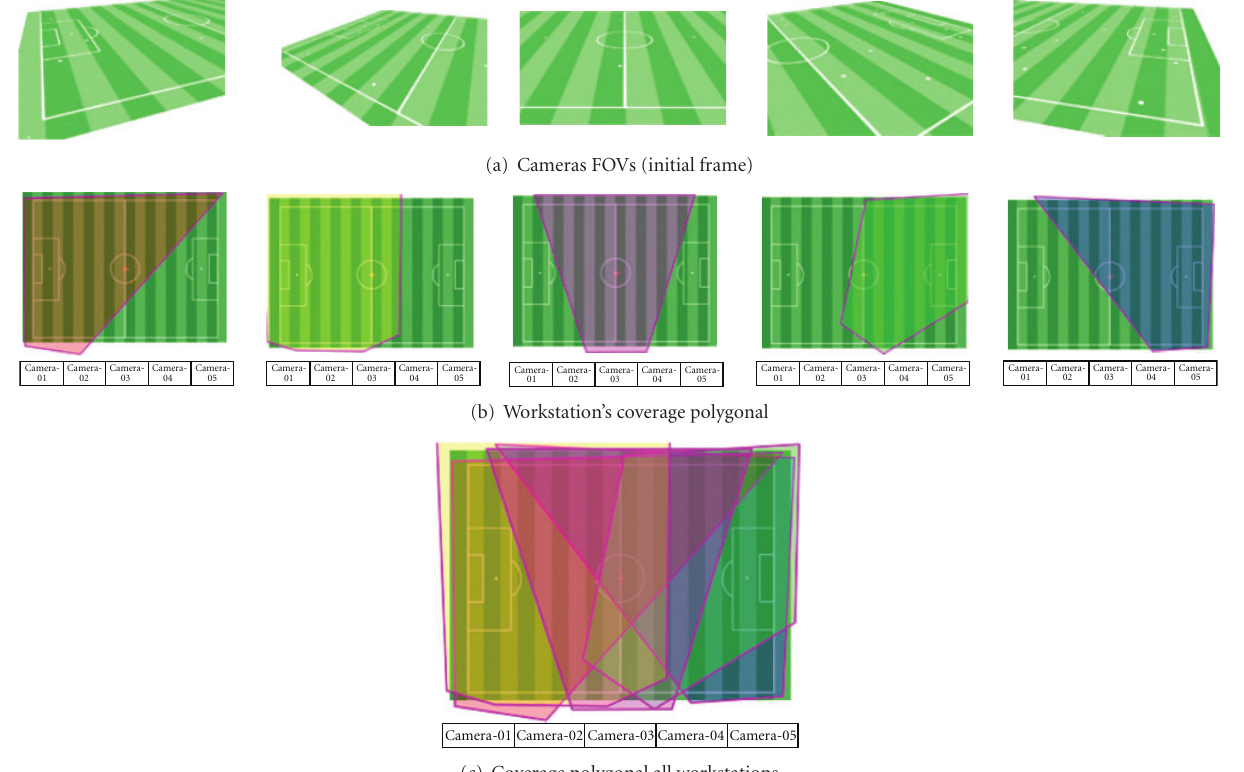
Figure 13: Workstations FOVs versus their illustration in the server coverage aid tool.